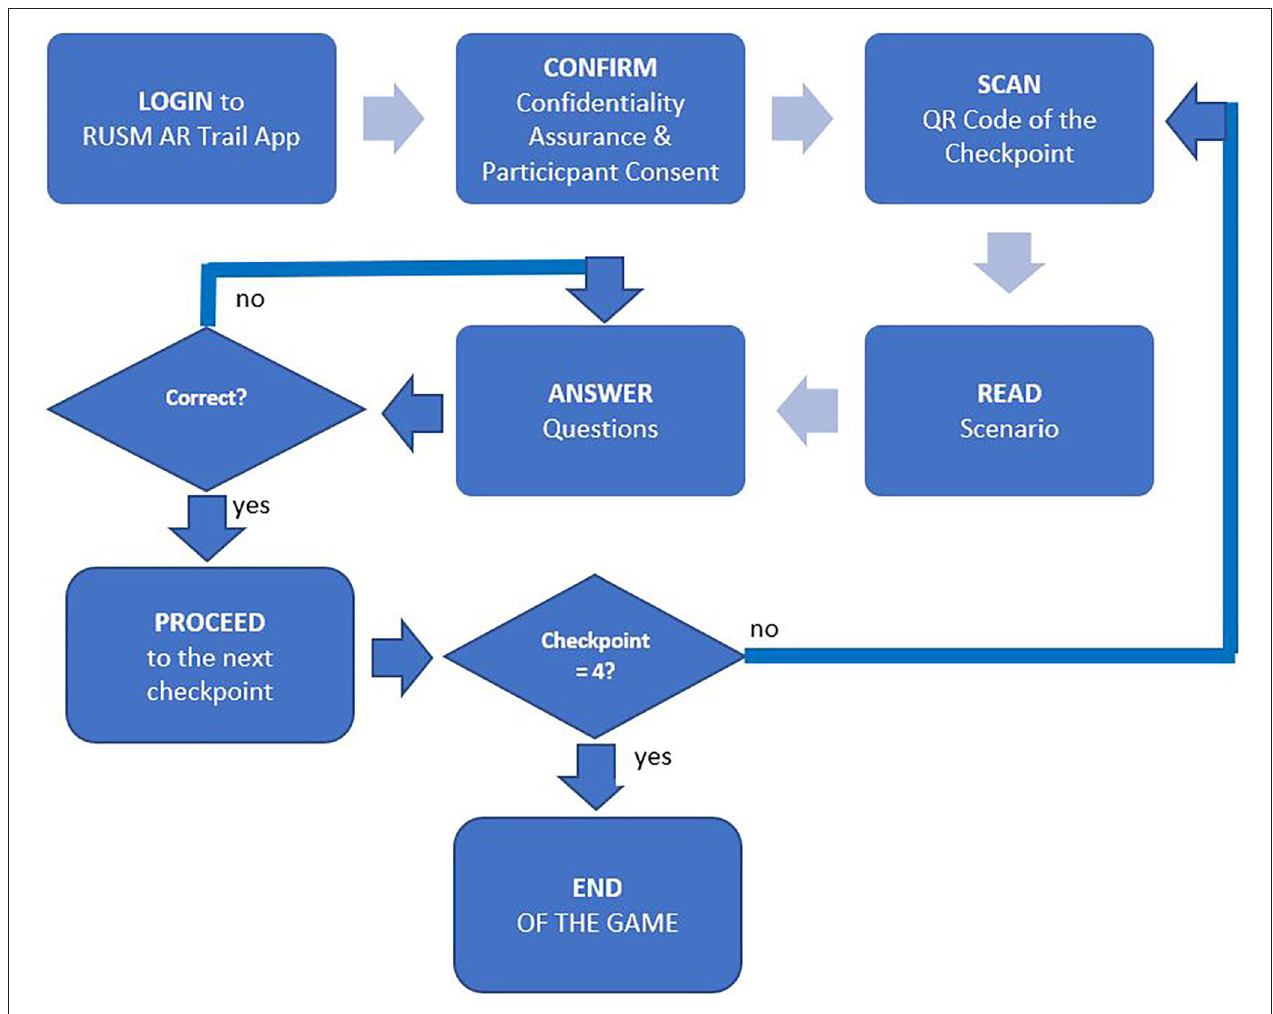
FIGURE 8 | Game Flowchart.